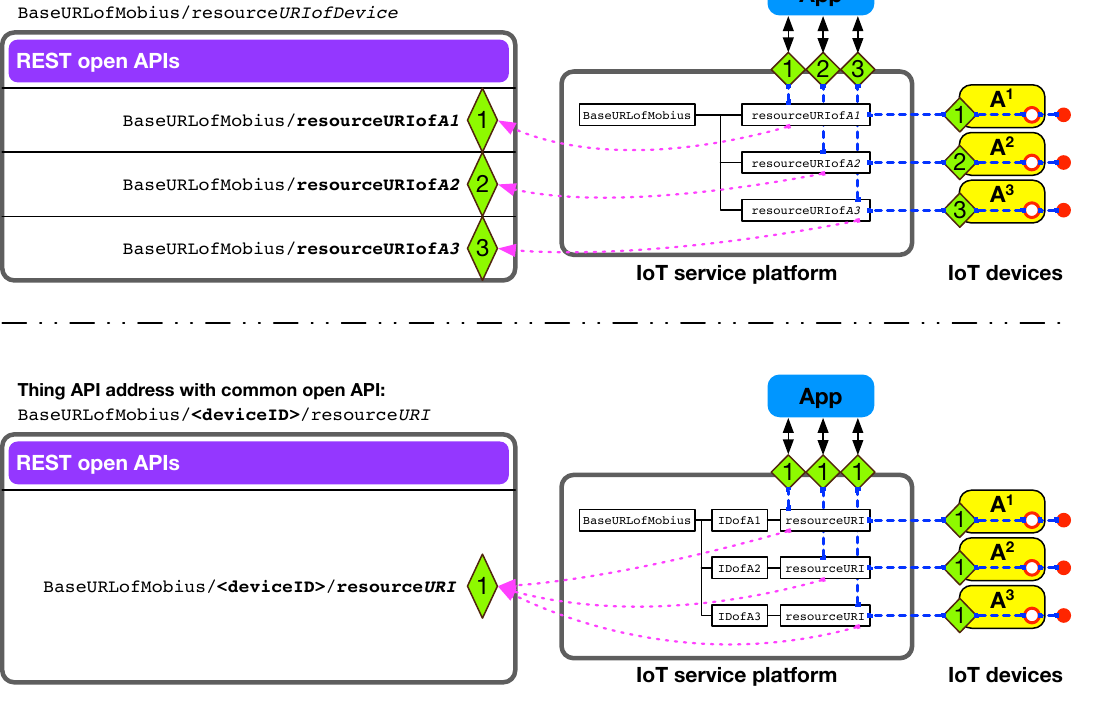
Figure 9. Application development support with reusable common open APIs by introducing the device ID into the resource hierarchy of the IoT service